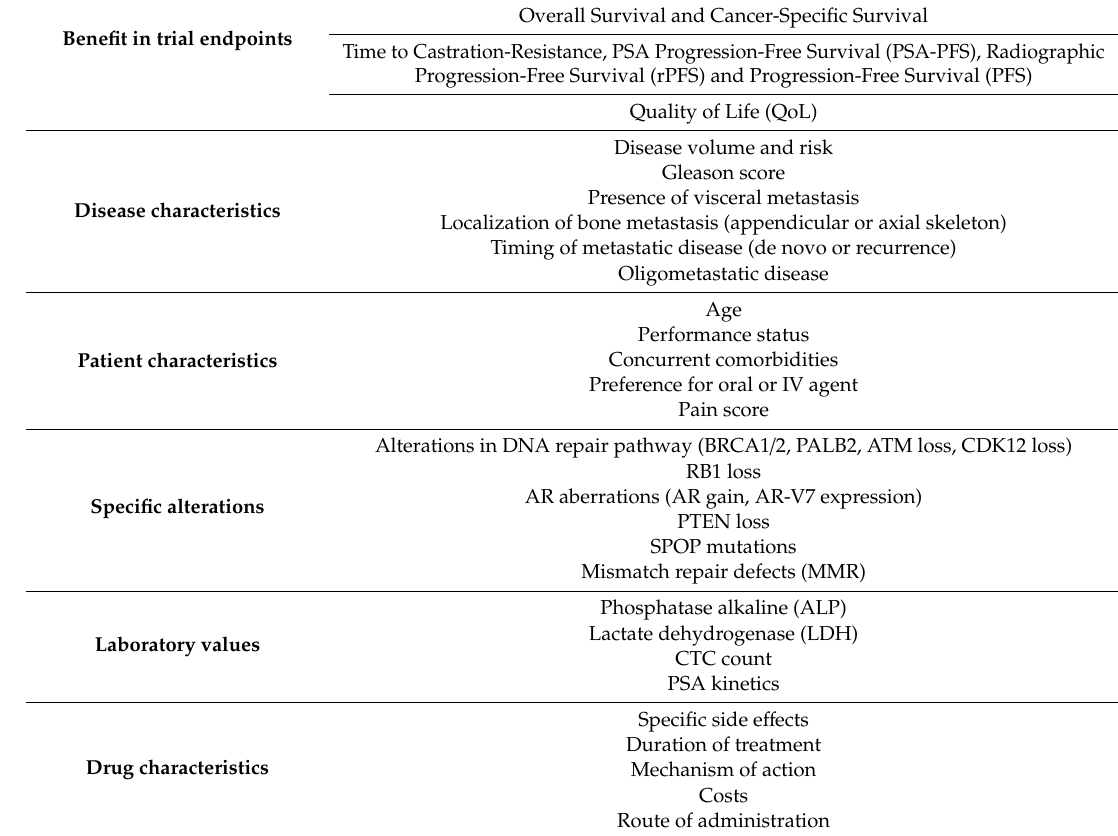
Table 4. Potential decision-making factors in